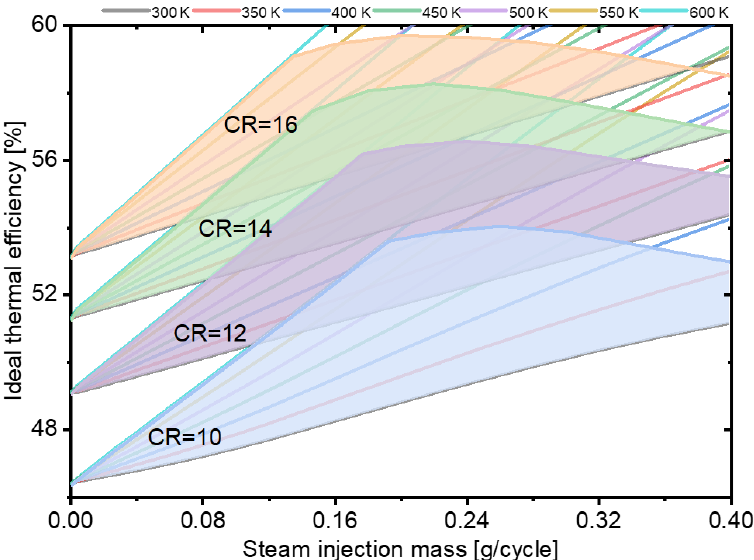
Figure 9. Thermal efficiency and its boundary at different compression ratios (P steam = 20 MPa; P intake = 0.1 MPa).